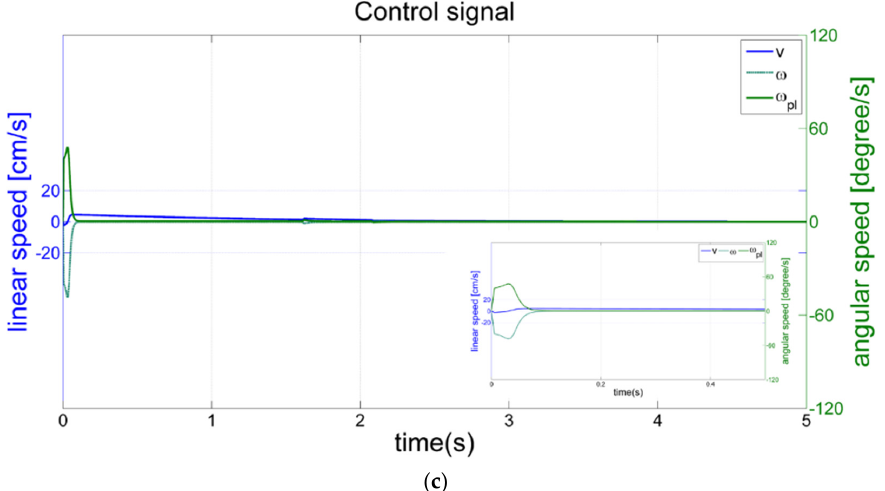
Figure 8. Simulation of the control signals: linear and angular speeds applying the ( a ) IBVS, ( b ) PBVS, and ( c ) HBVS control algorithms.